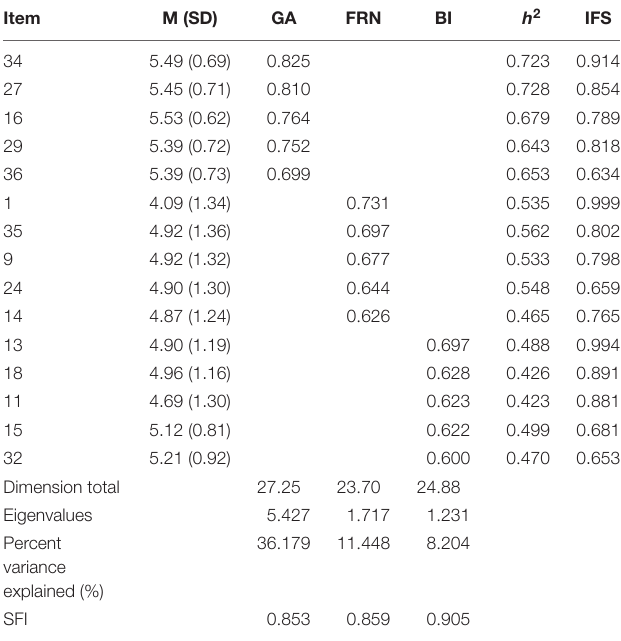
TABLE 2 | Three-dimensional filial piety scale exploratory factor analysis ( n =